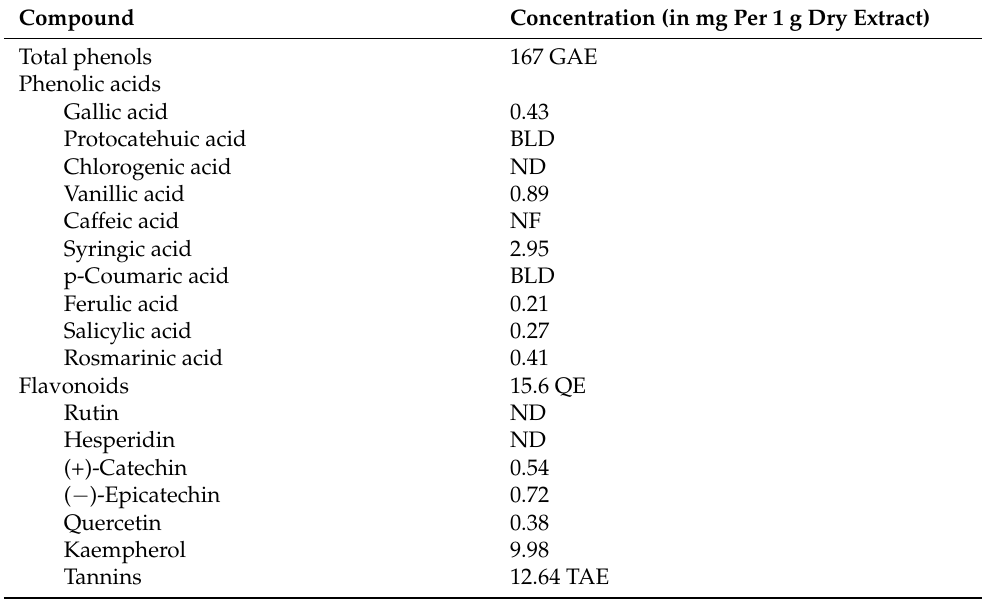
Table 2. Concentrations of some phenolic compounds of TCR extract in CHCl 3